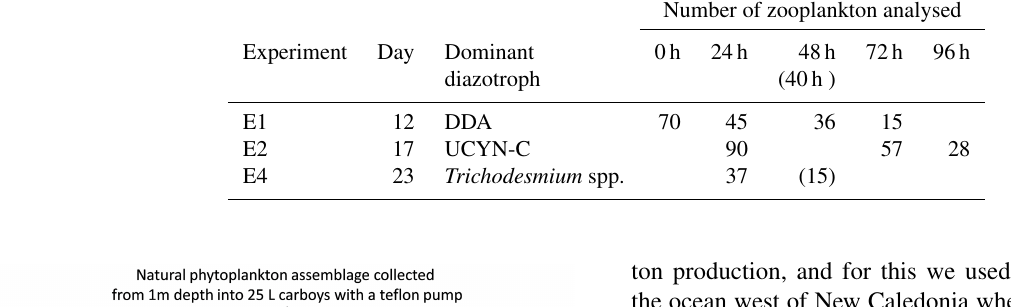
Table 2. Summary of three 15 N 2 labelled diazotroph grazing experiments, indicating number of zooplankton analysed per hourly time period. Number of zooplankton analysed